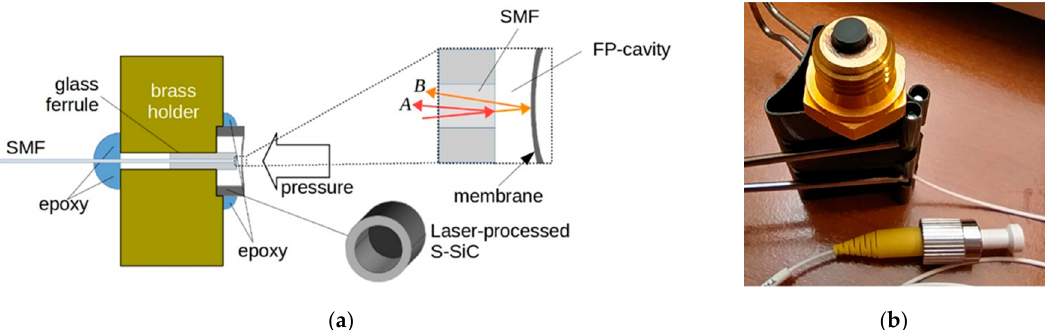
Figure 5. ( a ) Schematic of sintered SiC sensor. Single-mode fiber (SMF) end-face and diaphragm represent the Fabry–Perot cavity. Interference signal is generated by reflected signal at fiber end ( A ) and SiC membrane ( B ). ( b ) Laser manufactured S-SiC sensor mounted on the brass holder used for the experimental characterizations.